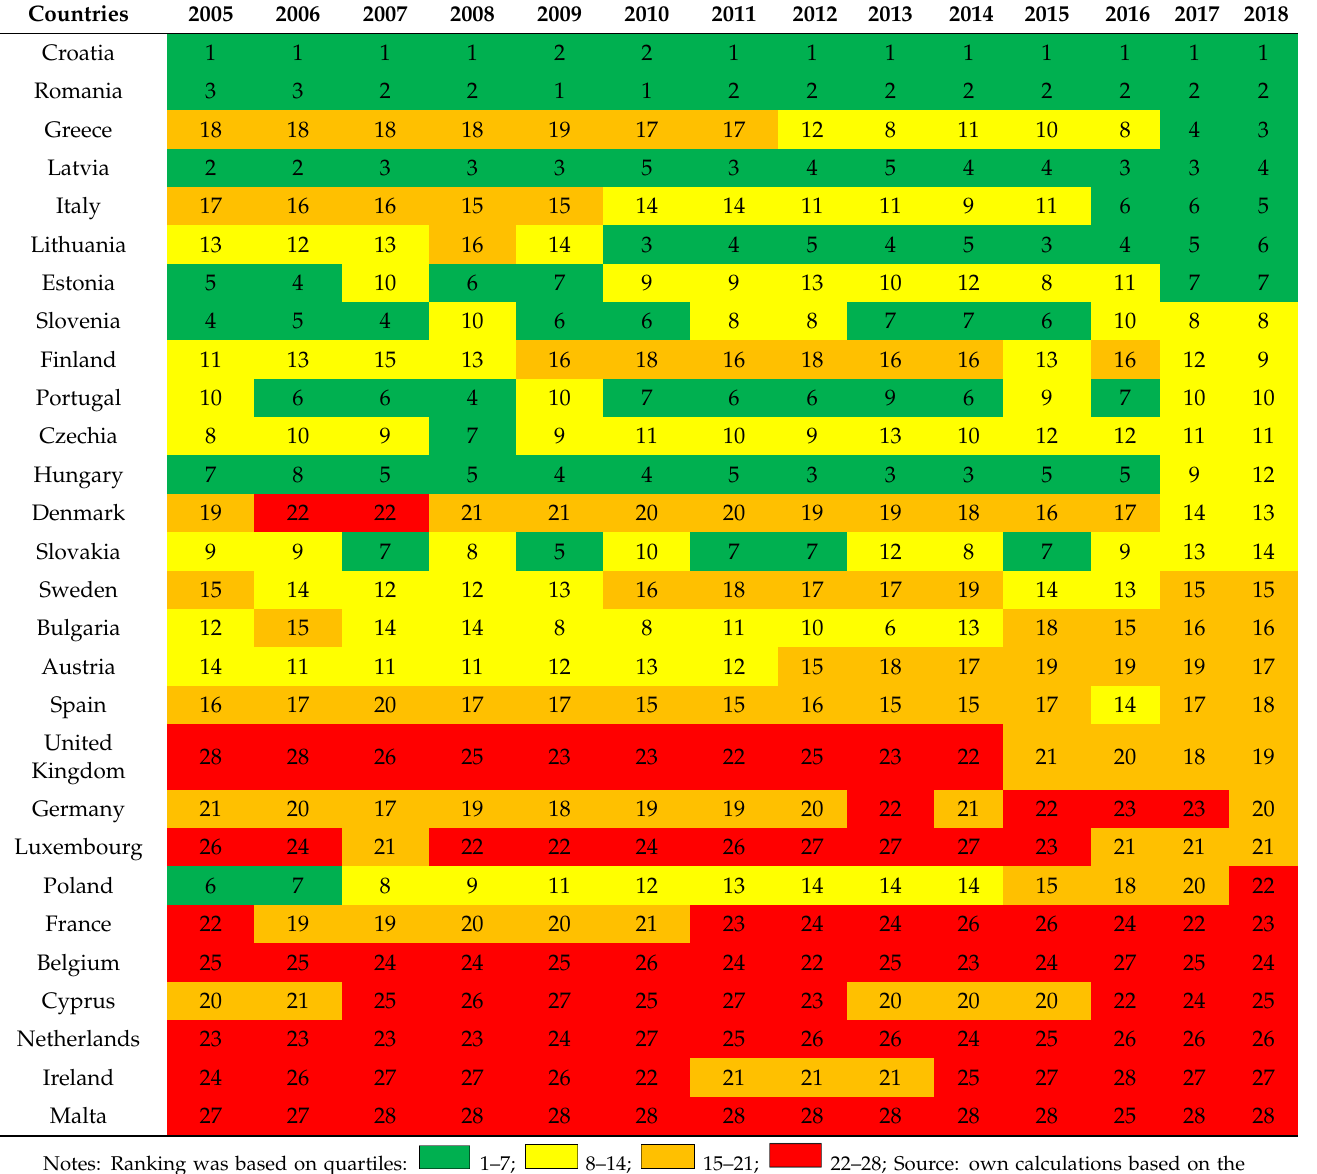
Table 7. Ranking of EU28 countries according to the Hellwig method in years 2005–2018.